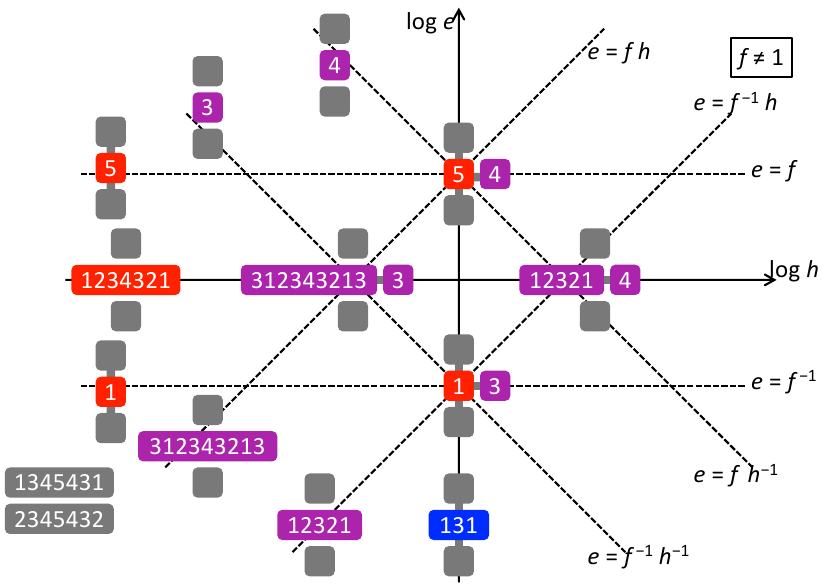
Figure 8 . Unbroken symmetries at each point in the three-dimensional space of brane con(cid:12)gu- rations C B . Every point enjoys the Weyl symmetry of W (( A 1 ) 2 ) generated by s 1 s 3 s 4 s 5 s 4 s 3 s 1 and s 2 s 3 s 4 s 5 s 4 s 3 s 2 . Along the axes or the dotted lines, an additional generator appears where the symmetry can be enhanced trivially to W (( A 1 ) 3 ) or drastically to W ( A 3 ). At the points where only two dotted lines cross, the symmetry is enhanced trivially to W ( A 3 (cid:2) A 1 ), which we do not depict explicitly, though the symmetry is enhanced drastically to W ( D 4 ) or W ( A 2 (cid:2) ( A 1 ) 2 ) if more than two lines